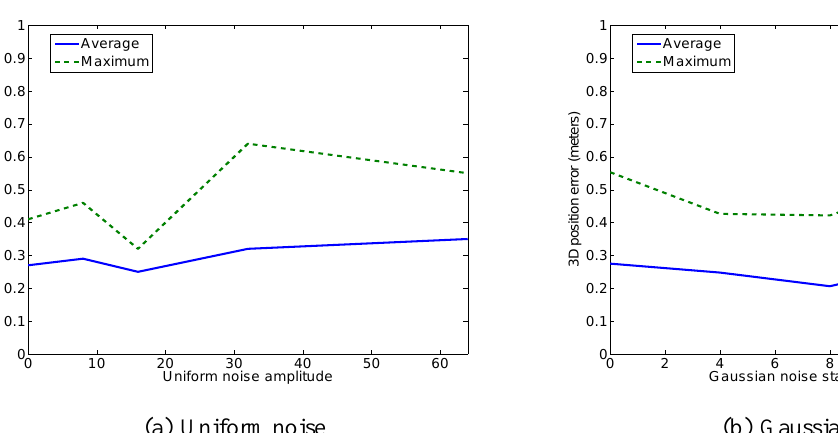
Figure 19. Error on the vertex 3D